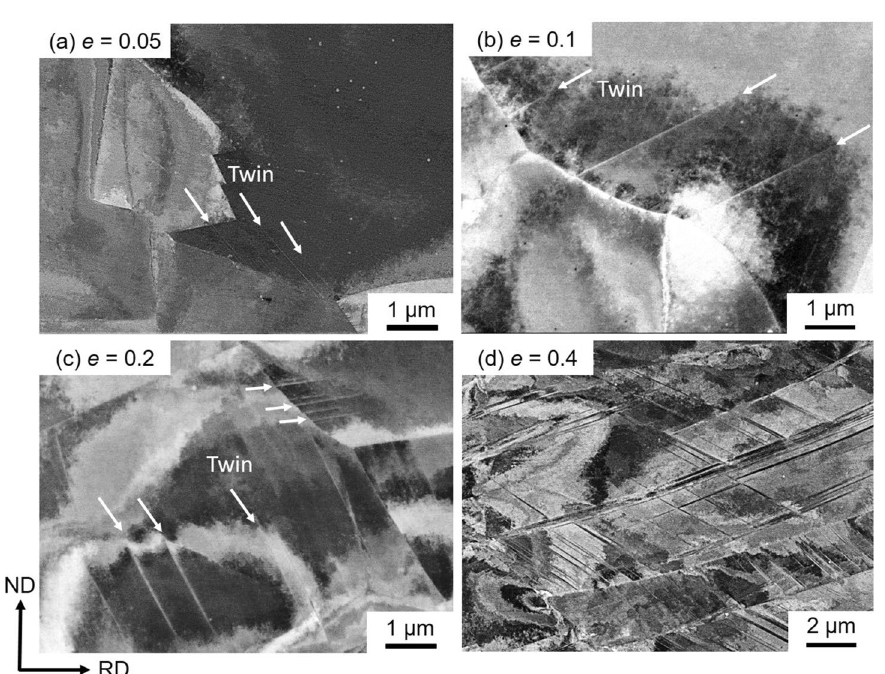
Figure 6. ECC images of the specimens with the mean grain sizes of 4.5 μm tensile-deformed to engineering strains of ( a ) e = 0.05, ( b ) 0.1, ( c ) 0.2 and ( d )